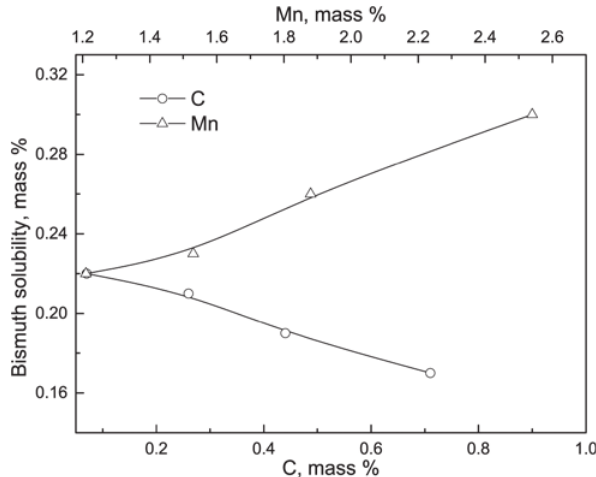
Fig. 5: Bismuth solubility as a function of alloy elements content (C, Mn) in liquid Bi-S steel